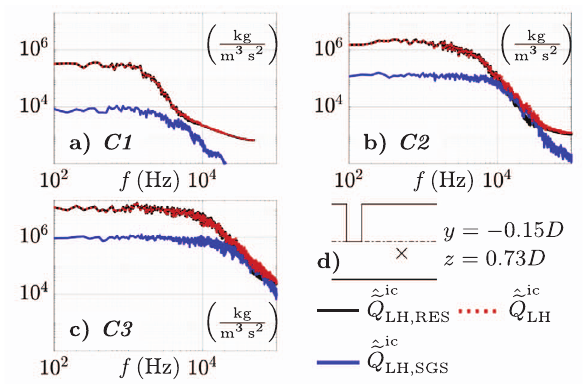
Figure 8. Spectra of the resolved, SGS contribution and full Lighthill source term for (a) C 1, (b) C 2 and (c) C 3, inside the high turbulent region marked in (d).